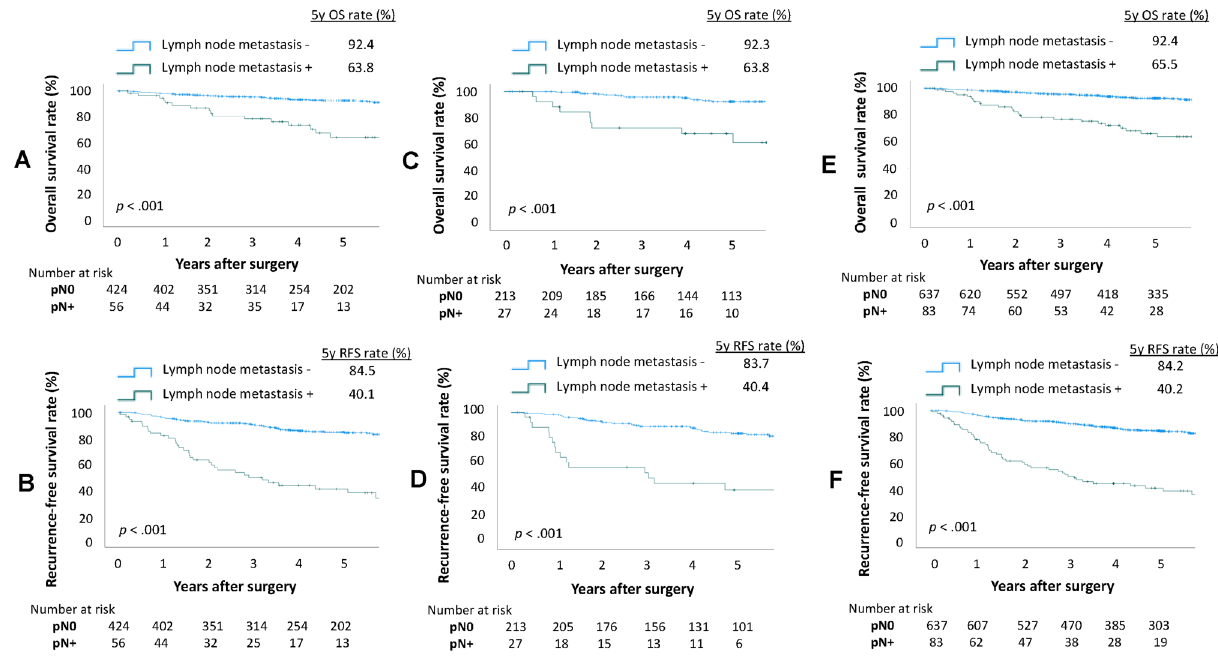
Figure 2. Overall survival and recurrence-free survival of clinical stage 0–IA patients according to status of lymph node metastasis status. ( A ) Overall survival and ( B ) recurrence-free survival of patients in the derivation cohort. ( C ) Overall survival and ( D ) recurrence-free survival of patients in the validation cohort. ( E ) Overall survival and ( F ) recurrence-free survival of patients in the entire cohort. pN0—pathological lymph node negative; pN + —pathological lymph node